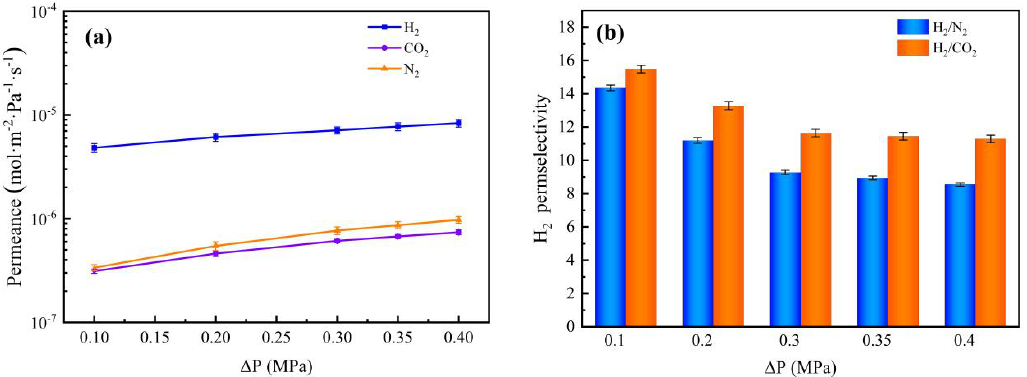
Figure 18. Effect of pressure difference on ( a ) gas permeances and ( b ) H 2 permselectivities of Nb/SiO 2 membrane at 200 °C.